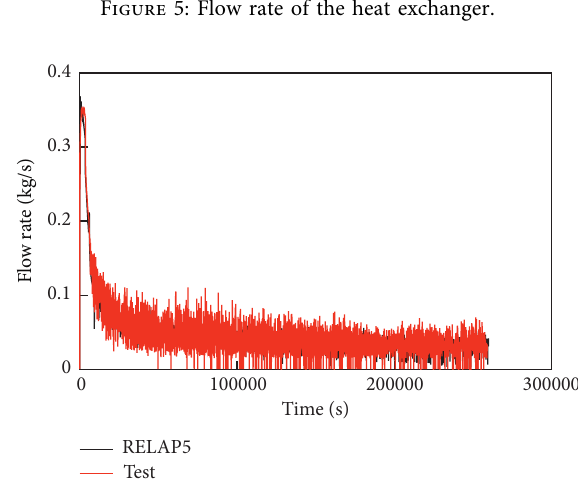
Figure 6: Flow rate of the SG feedwater line.